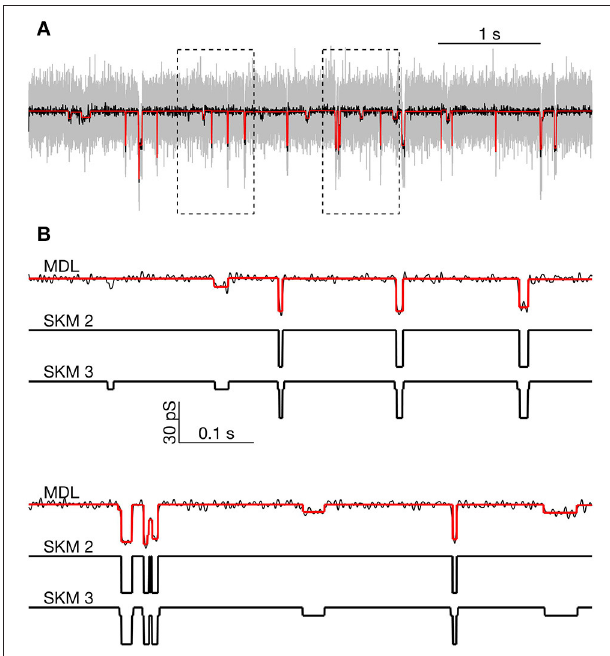
FIGURE 8 | Comparison of MDL and SKM analysis on data from PIEZO1 channels recorded at − 60mV. (A): Analyzed segment (part of recording in Figure 6 , indicated by rectangular inset in Figure 6C ). Raw data, gray; low-pass filtered, black. MDL idealized, red. Rectangles indicate regions expanded below. (B) : Expanded view of parts of the trace in (A) . Top: MDL idealized (red) and low-pass filtered data (black). Middle: Idealized by two state SKM (SKM2). Bottom: Idealized by 3 state SKM